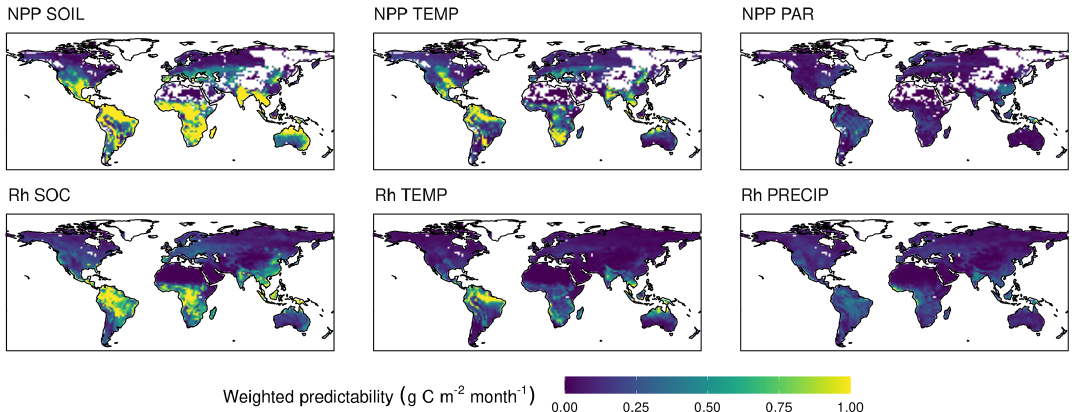
Figure 4. Contributing components to the weighted predictability ( wV c ) of NPP and Rh. The contributors to NPP predictability are the predictability of soil moisture (SOIL), temperature (TEMP), and photosynthetically active radiation (PAR). Contributors to Rh predictability are the predictability of soil organic carbon (SOC), TEMP, and precipitation (PRECIP). The averaged predictability of the first 12 months lead time weighted by carbon flux anomaly of the ensemble means. The sum of all components of a flux type give the modelled total predictability of that flux.